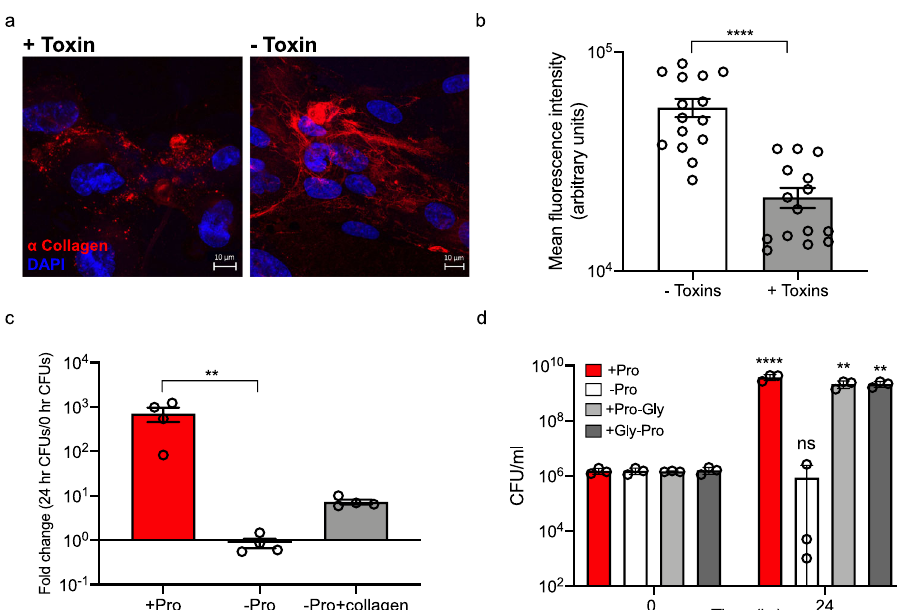
Fig. 4 Toxin-mediated degradation of collagen supports C. dif fi cile growth in vitro. a Representative images of DAPI (blue) and collagen (red) produced by IMR90 cells. Con fl uent cell monolayers were treated with 0.5 pM TcdA and TcdB and images were collected 12 h later. Collagen was stained with a mix of antibodies against collagen types I, III, and V in a 1:1:1 ratio; scale bar, 10 μ m. b Mean fl uorescent intensity of Alexa Fluor 568 stained collagen produced by IMR90 cells cultured in the presence or absence of 0.5 pM TcdA and TcdB for 15 h calculated using ImageJ software ( n = 15 fi elds of view for each condition). Statistical signi fi cance was determined by Mann – Whitney rank-sum test; **** p < 0.0001. c C. dif fi cile was grown in complete CDMM ( n = 4), CDMM lacking proline ( n = 4), or CDMM lacking proline and supplemented with heat-degraded collagen ( n = 4). CFUs/ml were enumerated at 0 and 24 h; ** p = 0.0051. Kruskal – Wallis test with Dunn ’ s correction for multiple comparisons was used to test for statistical signi fi cance. d C. dif fi cile was grown in complete CDMM ( n = 4), CDMM lacking proline ( n = 4), or CDMM lacking proline supplemented with puri fi ed Pro-Gly ( n = 4) or Gly-Pro ( n = 4) dipeptides. 24 h CFUs were compared to the 0 h CFUs for statistical tests; ** p = 0.0015, **** p < 0.0001. All data in ( b – d ) are presented as the mean and error bars indicate SEM. Statistical signi fi cance was determined by two-way ANOVA with Sidak ’ s multiple comparisons